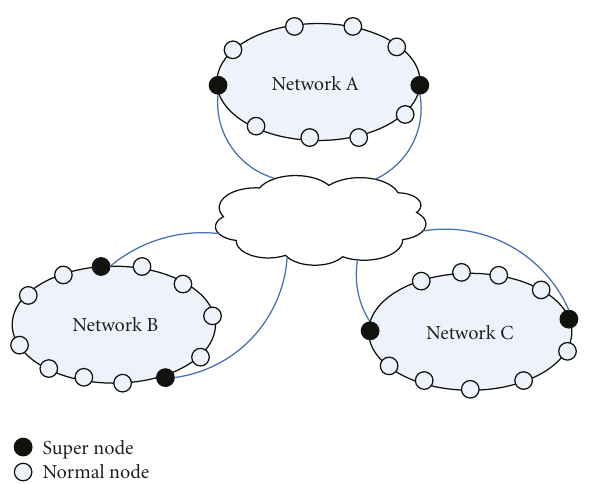
Figure 1: An illustration of network topology of the proposed